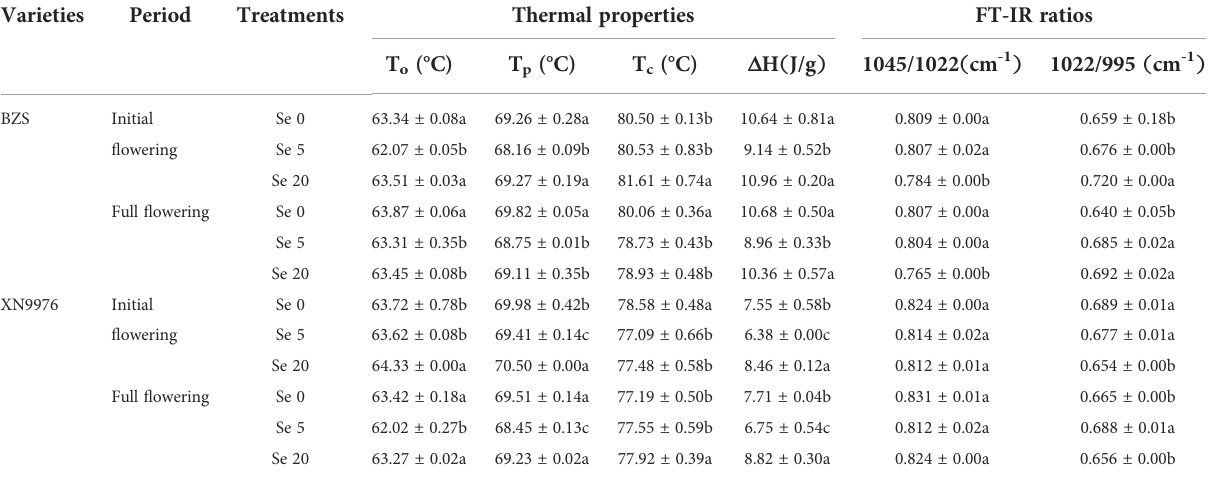
TABLE 2 Thermal properties and FT-IR ratios of common buckwheat starch under different selenium treatment levels. Varieties